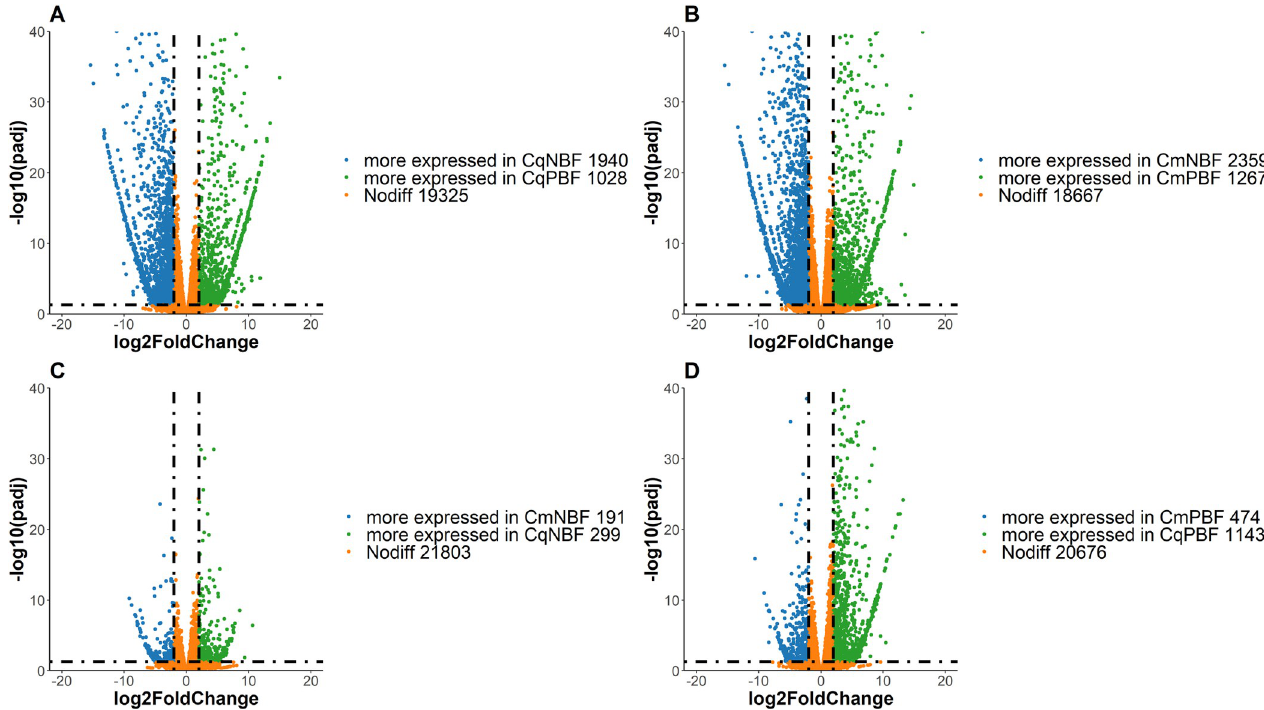
Fig 1. Volcano map of the differentially expressed antennal transcriptome genes (|log2FC| > 2, padj < 0.05). The green dots indicate significantly upregulated (more expressed in latter group) genes, the blue dots indicate significantly downregulated genes (more expressed in former group), and the orange dots represent nonsignificantly different genes. Fig 1A: Genes of Cx . pipiens quinquefasciatus before and after blood feeding; Fig 1B: genes of Cx . pipiens molestus before and after blood feeding; Fig 1C: genes of Cx . pipiens quinquefasciatus and Cx . pipiens molestus before blood feeding; and Fig 1D: genes of Cx . pipiens quinquefasciatus and Cx . pipiens molestus after blood